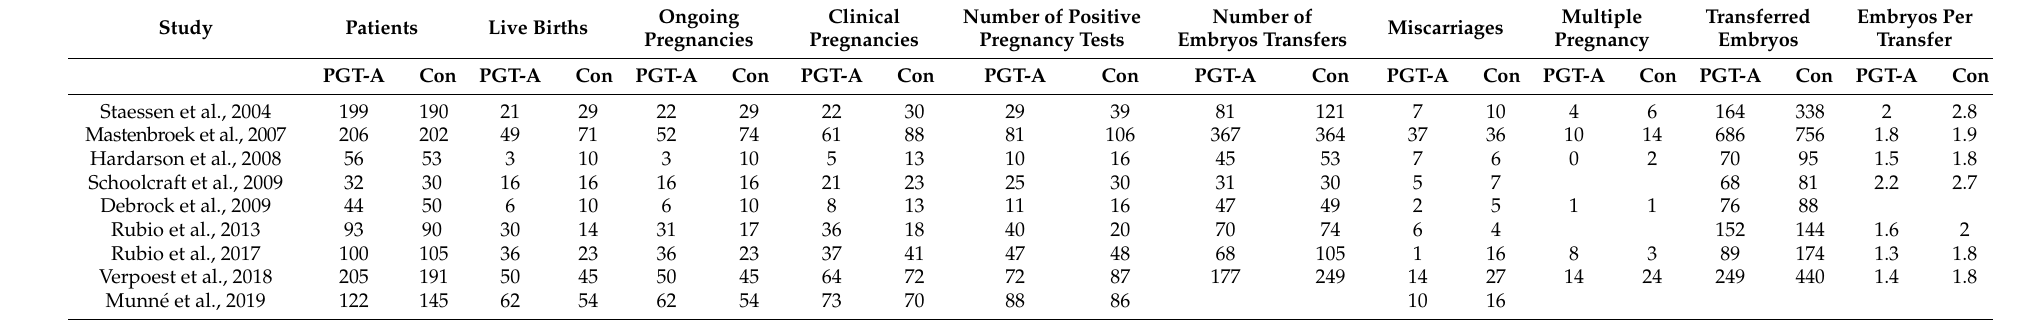
Table 2. Pregnancy outcomes of included